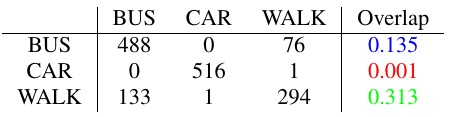
TABLE III Feature induced matrix using two dimensional